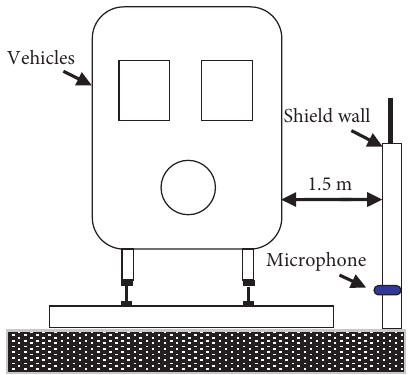
Figure 1: Measurement scheme